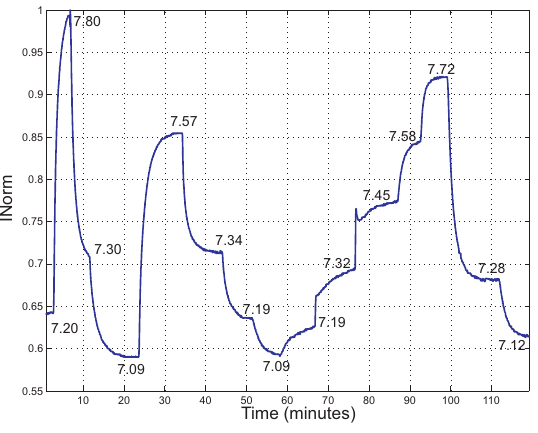
Figure 9. I versus time acquired at different pH values in the range 7.0–8.0. The steady Norm state pH values of the solution as measured by the reference instrument are reported close to the curve.